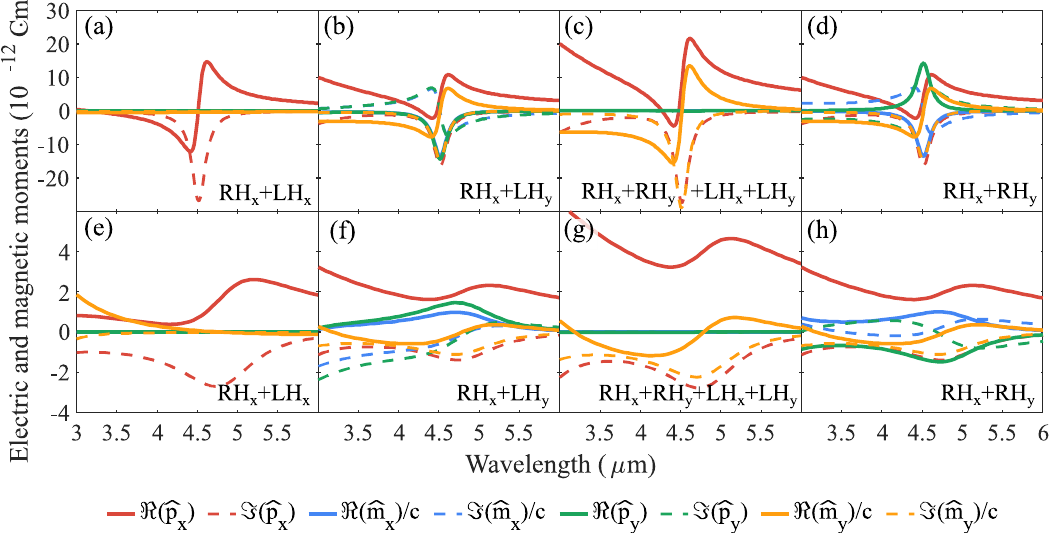
Figure 3. The real and imaginary parts of electric and magnetic dipole moments of the required combination and arrangement of RH and LH helices for polarization conversion in accordance with conditions (6), (8), (10) and (12) for ( a – d ) horizontally oriented and ( e – h ) vertically oriented helices,